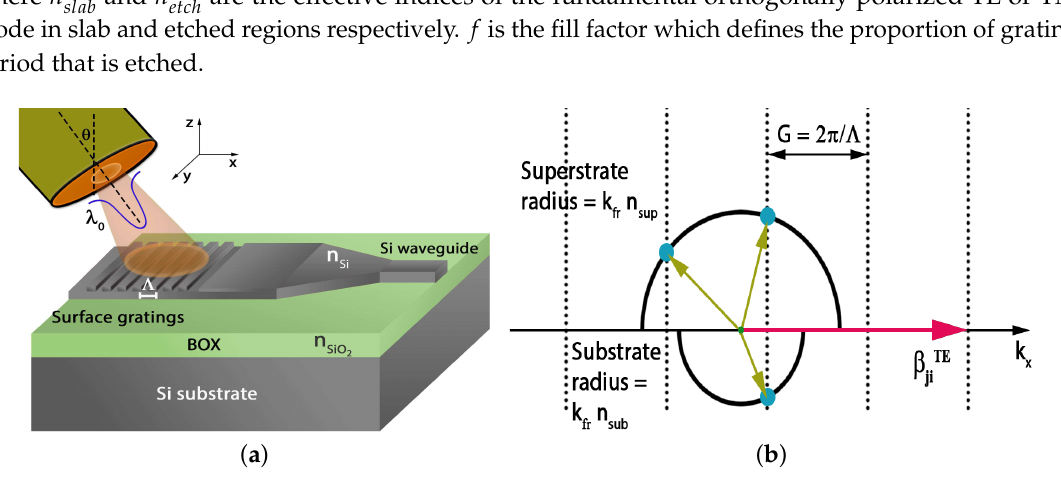
Figure 2. ( a ) Three dimensional (3-D) schematic of a Silicon-on-Insulator (SOI) based fiber to chip surface grating coupler with adiabatic tapers; ( b ) k - space representation of the grating phase matching condition. k fr n sup corresponds propagation constant of superstrate and k fr n sub of substrate and G is the grating reciprocal